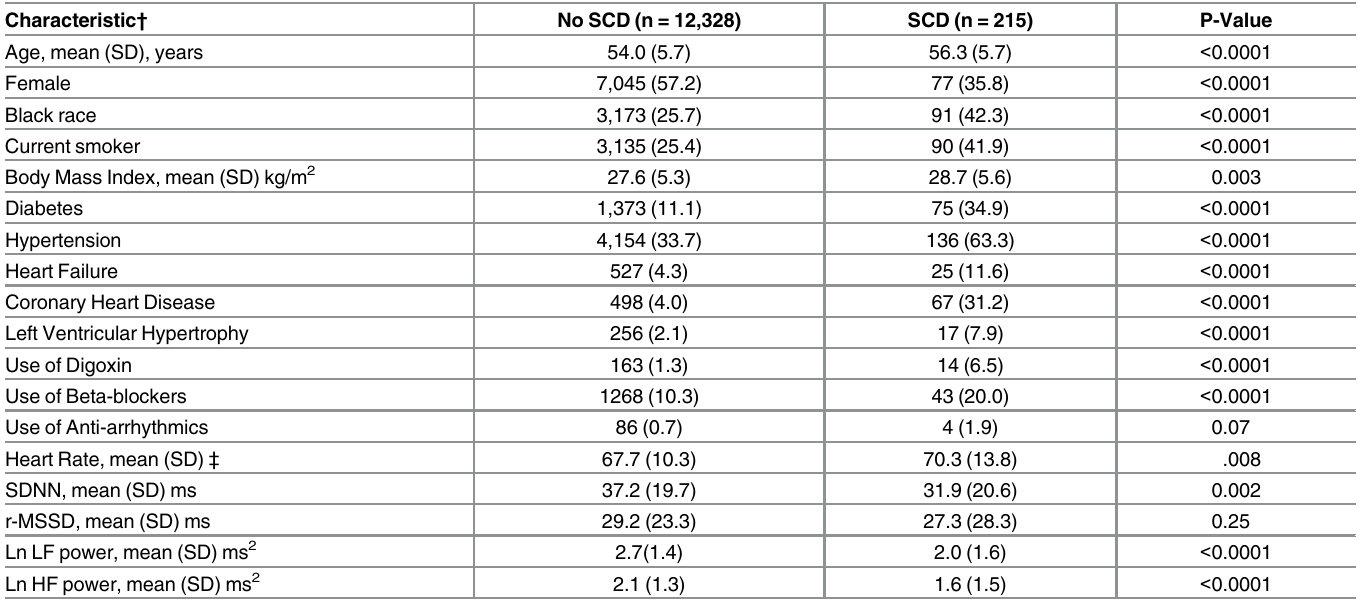
Table 1. Baseline Participant Characteristics by Sudden Cardiac Death Status, Atherosclerosis Risk in Communities Study, 1987 – 2001. Characteristic